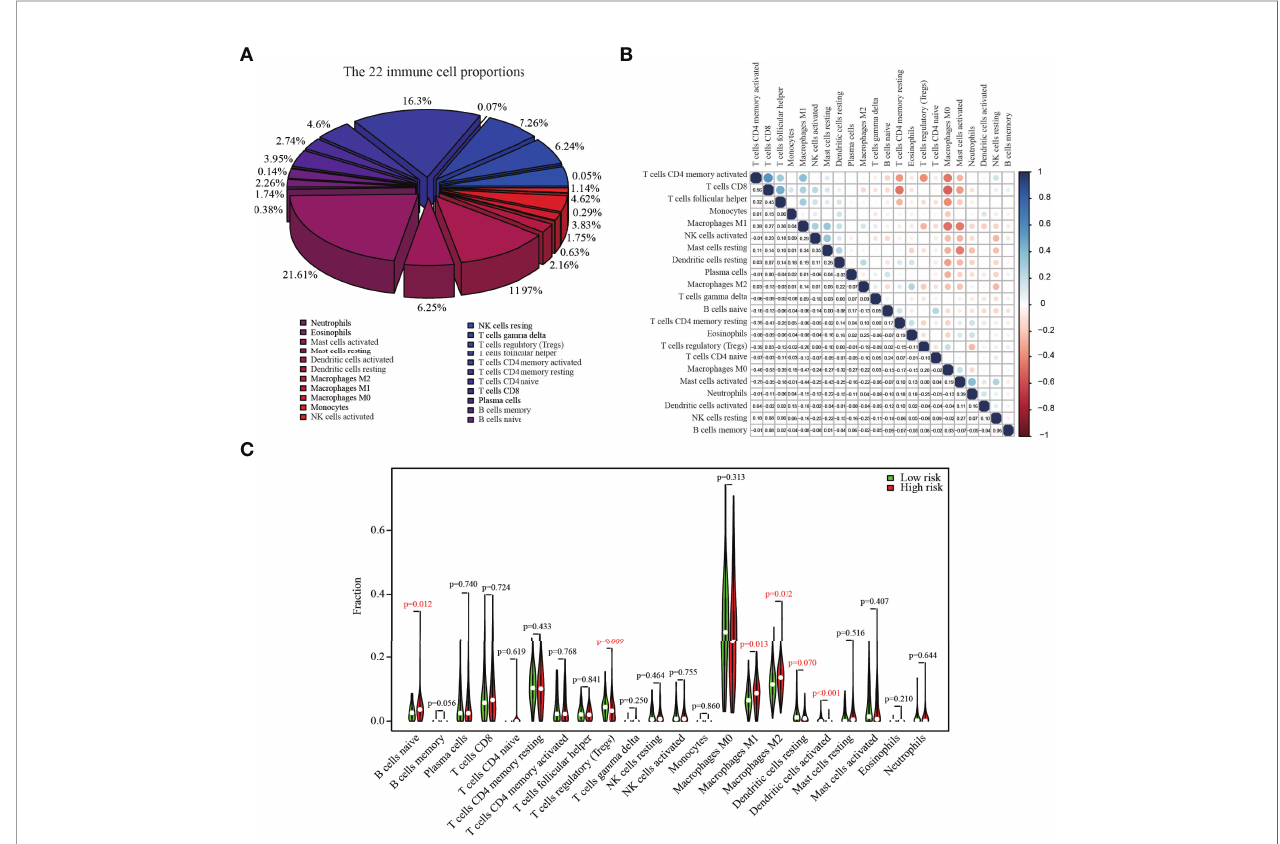
FIGURE 4 | The composition of 22 immune cells in colon cancer tumors from the TCGA dataset. (A) The relative abundances of 22 immune cells in the tumor tissue of colon cancer patients. (B) The correlation matrix between different cell types; the size of the circle represented the degree of correlation. (C) Fractions of in fi ltrating immune cells in high versus low risk score groups.